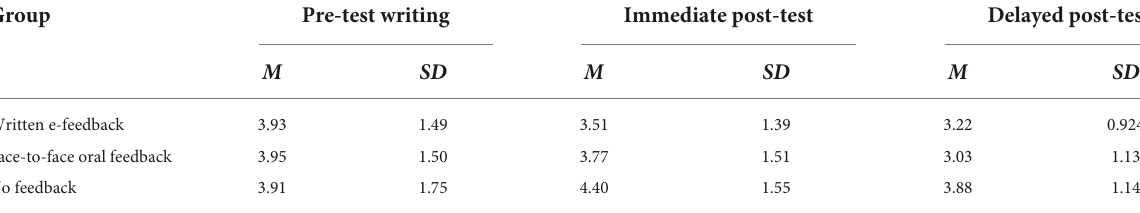
TABLE 1 Descriptive statistics: three feedback types at pre-and post-tests. Group